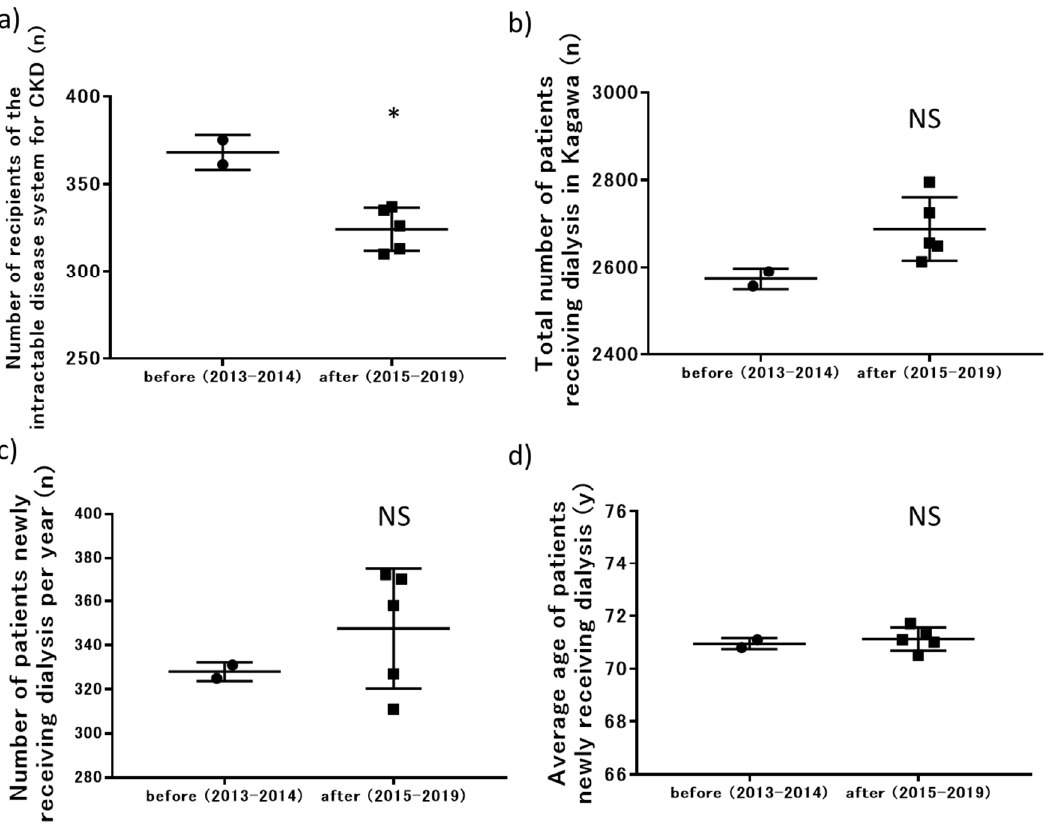
Figure 6. Changes in outcomes related to prefecture-wide data for all insurance-related factors after the start of the prefecture-wide CKD initiative: ( a ) number of recipients of the intractable disease system for CKD; ( b ) total number of patients receiving dialysis in Kagawa; ( c ) number of patients newly receiving dialysis per year; ( d ) average age of patients newly receiving dialysis. CKD, chronic kidney disease. * p < 0.05 versus before the initiative (2013–2014).